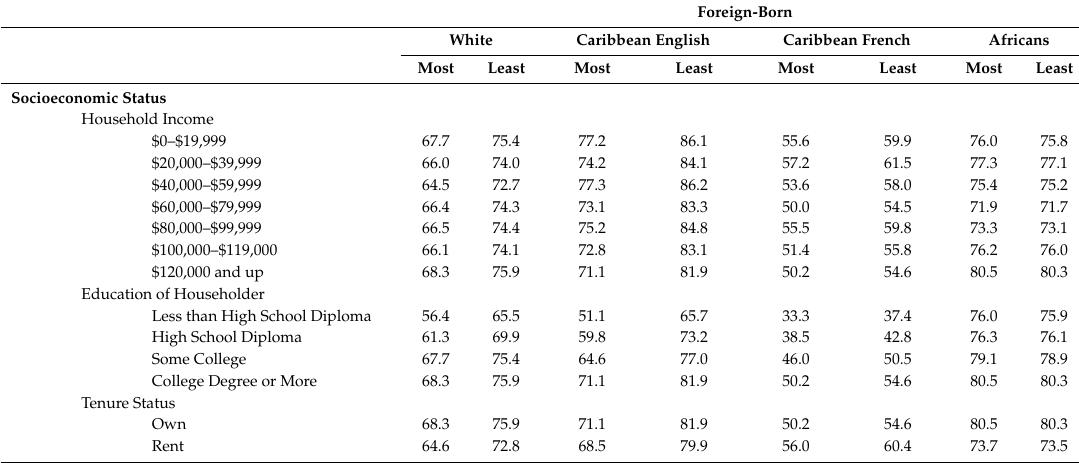
Table 5. Predicted Probabilities of Living in Developing Suburbs Di ff erentiated by Each Foreign-Born Group’s SES and Acculturation